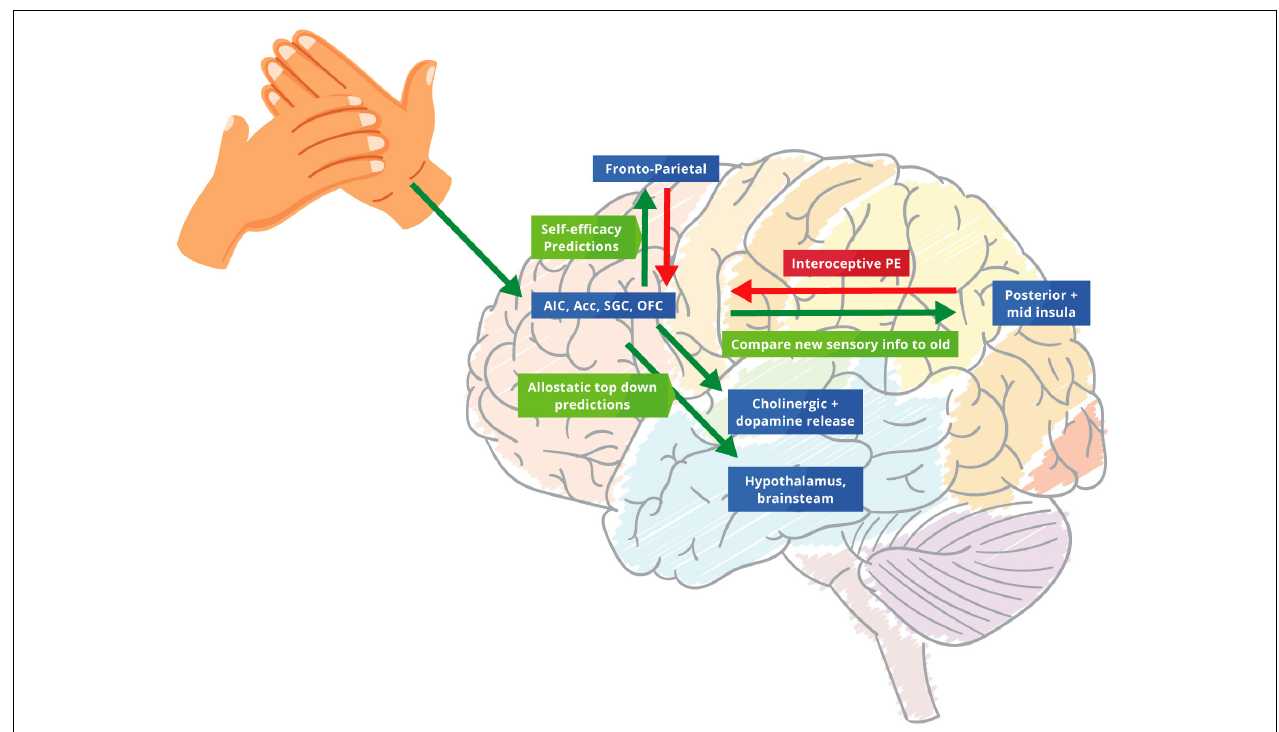
FIGURE 1 | The biofeedback loop of therapeutic touch. Green arrows: predictions errors; Red arrows: predictions. Touch biofeedback loop adapted from Sterling and Eyer (1988) and Fotopoulou et al. (2022) to help modify and adjust the importance of priors through new allostatic predictions from therapeutic touch. We suggest that the AIC, ACC, SGC, and OFC create allostatic therapeutic touch predictions that underwrite interceptive prediction errors in the posterior and mid insula. These predictions modulate homoeostatic beliefs in the hypothalamus and brainstem. Descending projections from the AIC, ACC, OFC, and SGC replay top-down predictions to the mid and posterior insula to protect the new bottom-up stimulus of therapeutic touch. The ensuing prediction errors are then sent to the frontoparietal network that revises prior beliefs and future allostatic predictions, identifying more precise and newsworthy prediction errors for this specific situation for the